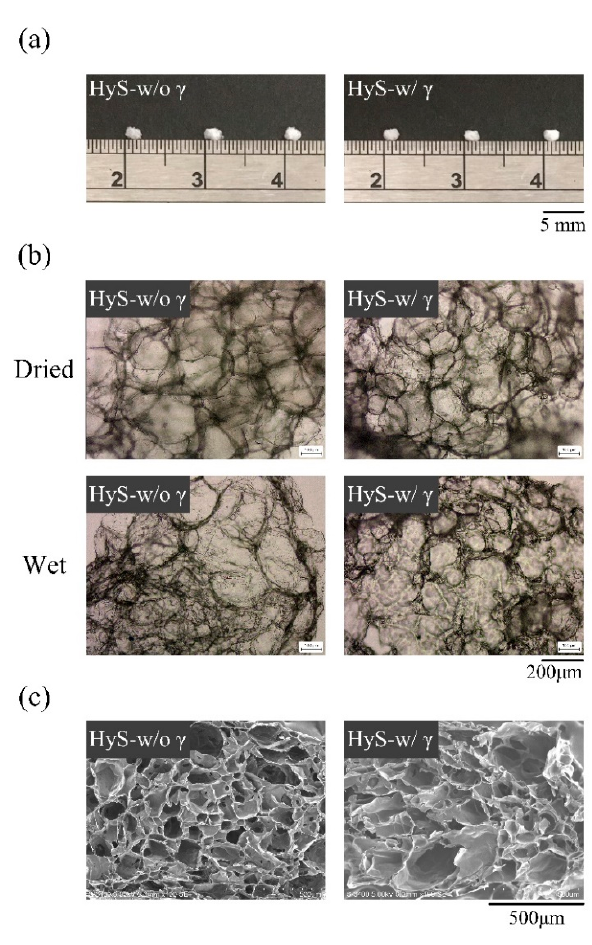
Figure 1. Freeze-dried hydrogel macrospheres after (HyS-w/ γ ) and before (HyS-w/o γ ) sterilization of internal macrosphere microstructures of ( a ) photographs, ( b ) OM images, and ( c ) SEM images.